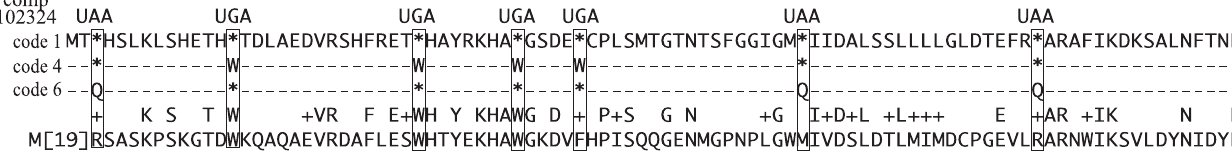
Fig 1. A sequence translated using three different genetic codes illustrating changes in BLASTx scores. The nucleotide sequence from comp102324 was translated as a query under three different genetic codes with the dashes (-) representing identically translated codons. The top amino acid translation uses NCBI genetic code 1, where UGA, UAA, and UAG are all interpreted as stop ( � ). These codons are shown above the amino acid translation and are boxed. The NCBI genetic code 4 translates UGA as tryptophan (W), increasing the number of pairwise identities in this example by three, and the number of positive matches by one (identified in the midline with +). However, three UAA stop codons still interrupt the open reading frame. The third translation using NCBI code 6 interprets UAA and UAG as glutamine (Q), which does not increase the number of pairwise identities, but does increase the number of positives, or similar amino acids by two. In this example there are no UAG codons. The top blast hit ( Candida tenuis ATCC10573 gi 575519749) and pairwise identities or positives when translating all three stop codons as amino acids are shown below the different translations.